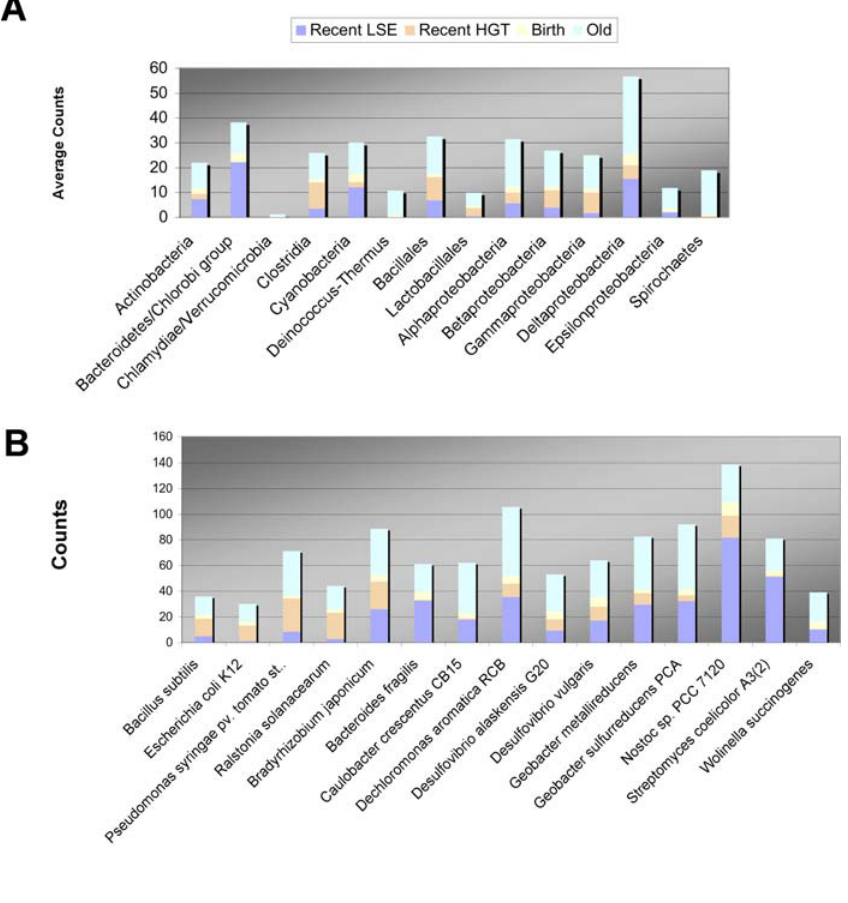
Figure 3. Summary of Evolutionary Events The number of events inferred for different bacteria is summarized in this figure. (A) Average numbers for the major taxonomic groups used in this study. (B) Specific numbers for targeted genomes (those with colored symbols in Figure 1).